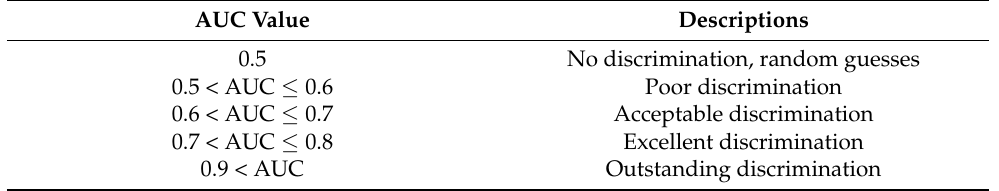
Table 3. AUC value